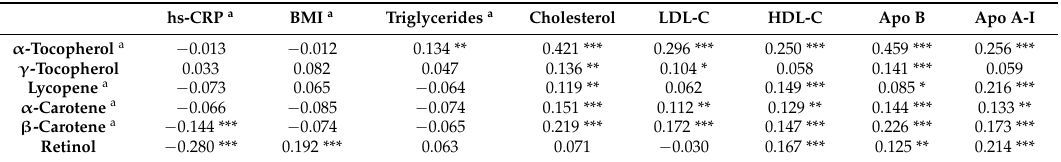
Table 2. Pearson correlation coefficients between plasma concentrations of fat-soluble antioxidants and lipids, apolipoproteins, high sensitivity-CRP and BMI in children. hs-CRP a BMI a